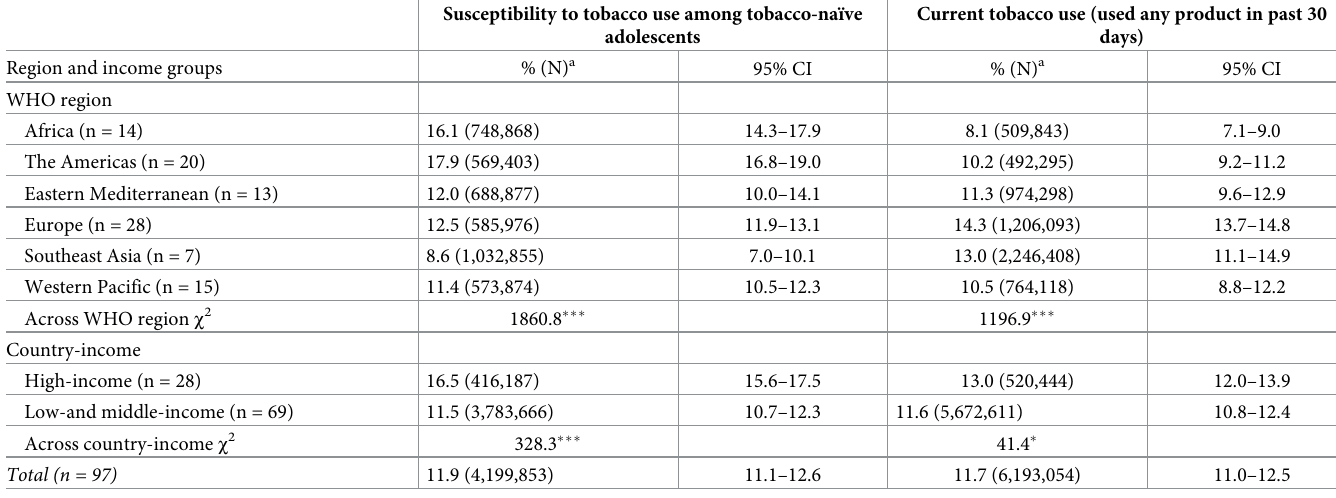
Table 1. Prevalence of susceptibility to tobacco use among tobacco-na ï ve adolescents, and use of any tobacco product in the past 30 days among adolescents, aged 13–15 years, from 97 countries in the Global Youth Tobacco Survey, 2013–2017, by WHO region and country-income